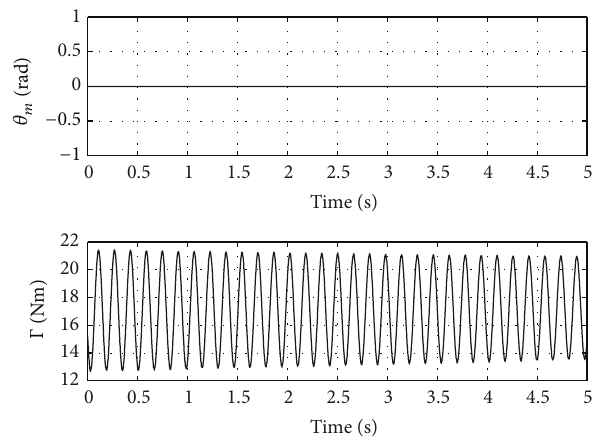
Figure 6: Experiment type 3: motor position and torque measure- ment for mass 𝑚 2